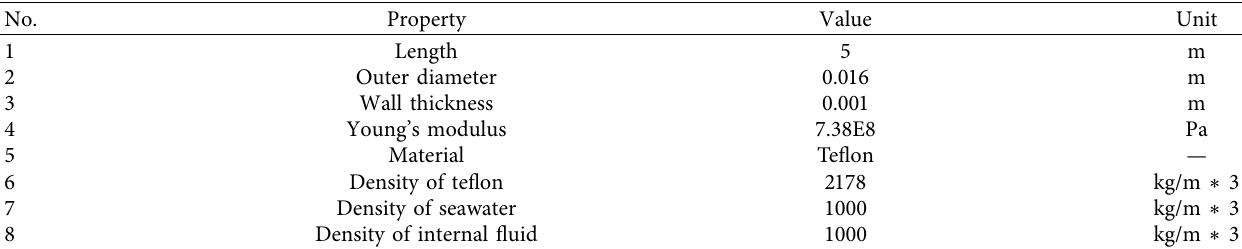
Figure 10: VIV test of TTR considering the platform heave motion. (a) Sketch of the test. (b) The linkage device. (c) Variable stroke. (d) Frequency control instrument. Table 4: Specifications of the riser